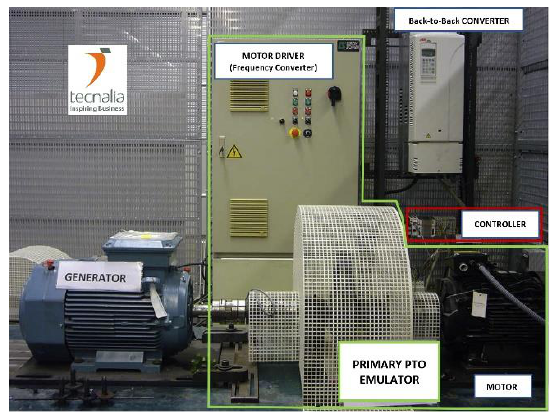
Figure 18. Wave flume of the Maritime Laboratory at the University of Padua. Energies 2020 , 13 , x FOR PEER REVIEW